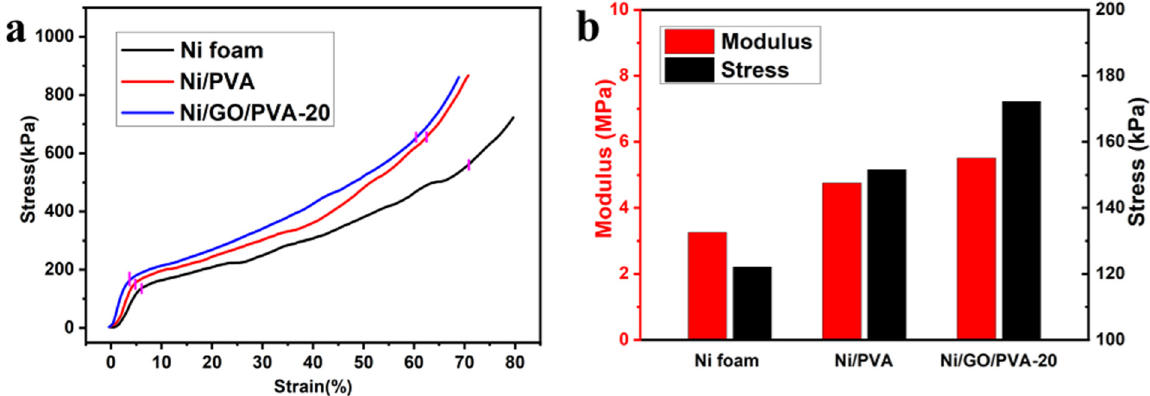
Figure 5: Compression properties of Ni foam, Ni/PVA, and Ni/GO/PVA - 20 ( a ) compression stress – strain curves; ( b ) modulus and maximum